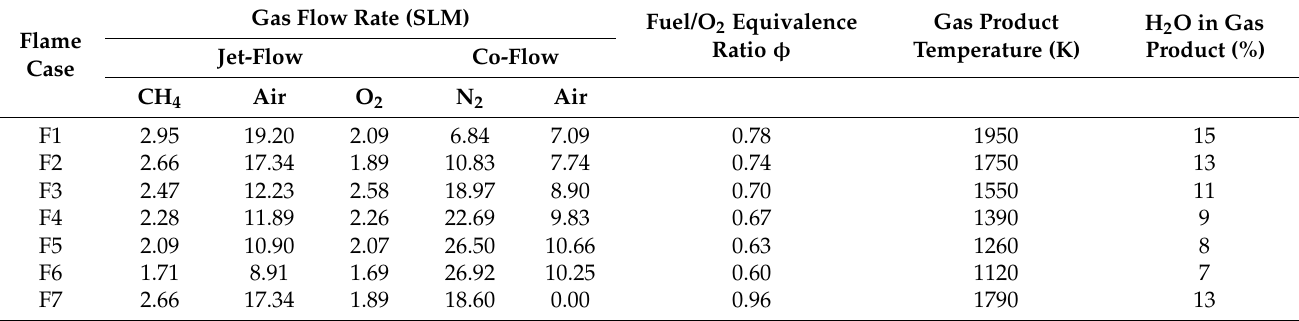
Figure 3. Schematic of the multijet burner ( a ), the TDLAS setup ( b ), and the measurement of HCN and C 2 H 2 above burning nylon 66 strips ( c ). PD: photodiode. (Reproduced from Weng et al. [25] Copyright 2020 Elsevier.) Table 1. Summary of the flame conditions, with corresponding temperature measured at 5 mm above the burner outlet and water concentration in the gas product.